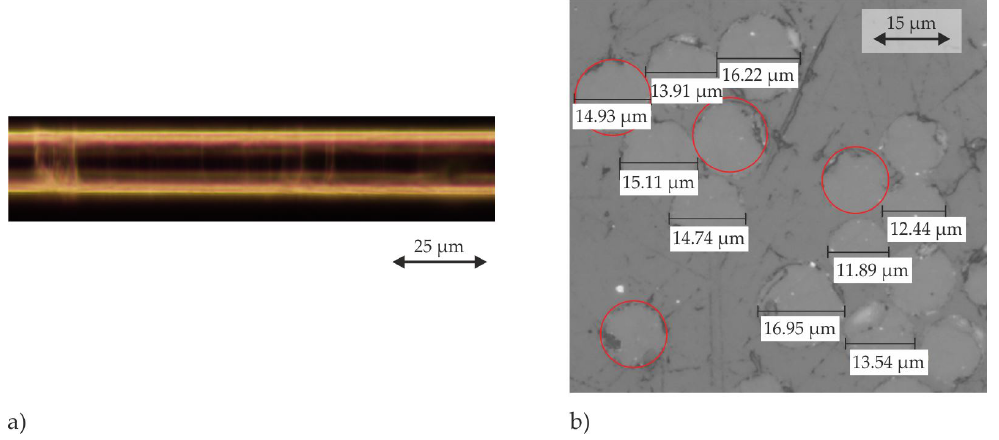
Figure 1. Micrographic characterisation of ( a ) a single fibre surface and ( b ) cross-sections of fibres to measure the fibre diameters. Table 1. Glass fibre engineering constants and geometric